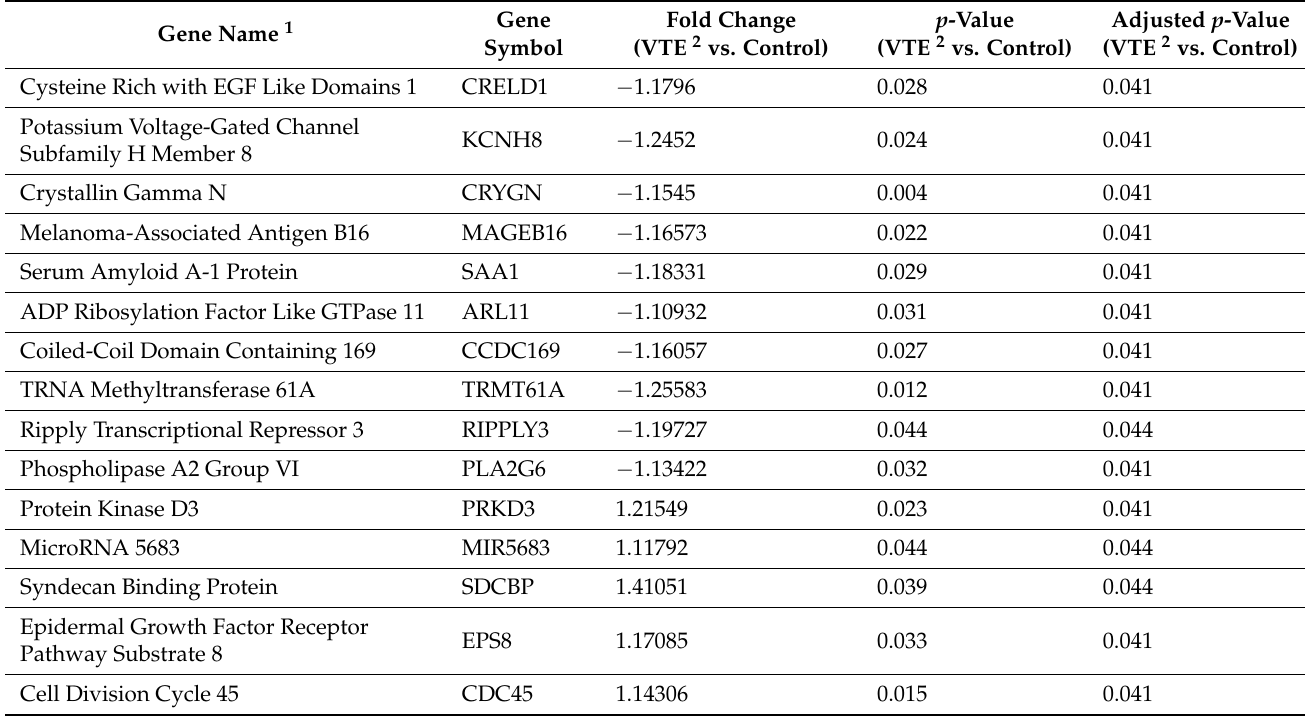
Table 3. Differentially expressed genes between patients with venous thromboembolism and controls, in the intestinal